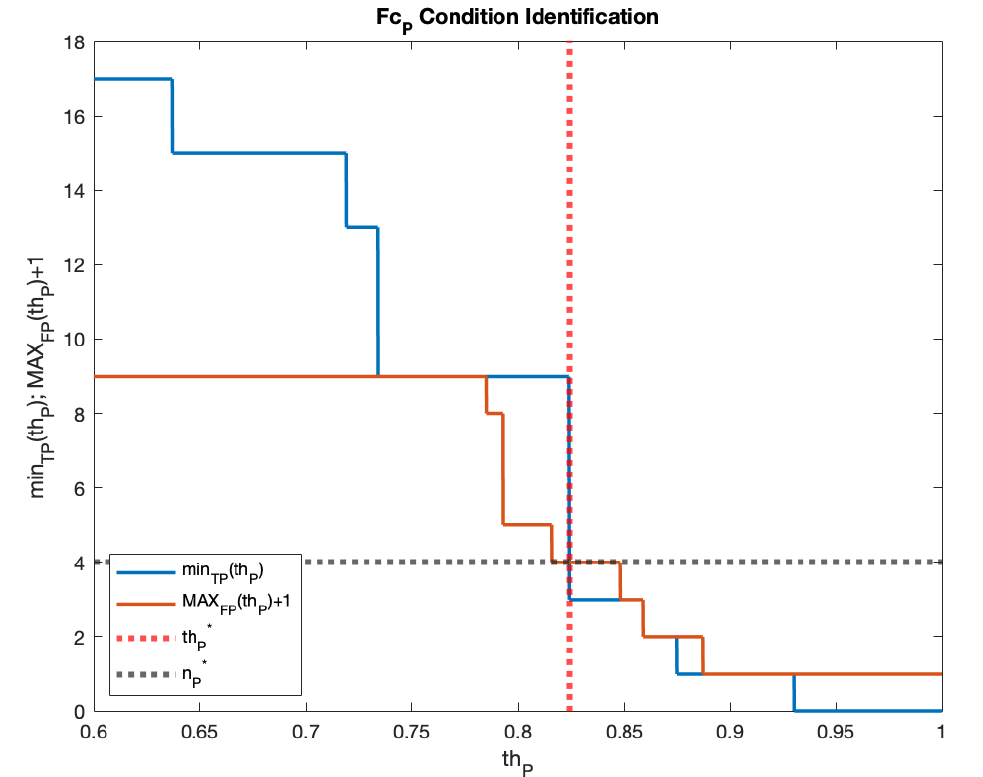
Figure 7. Fc P condition